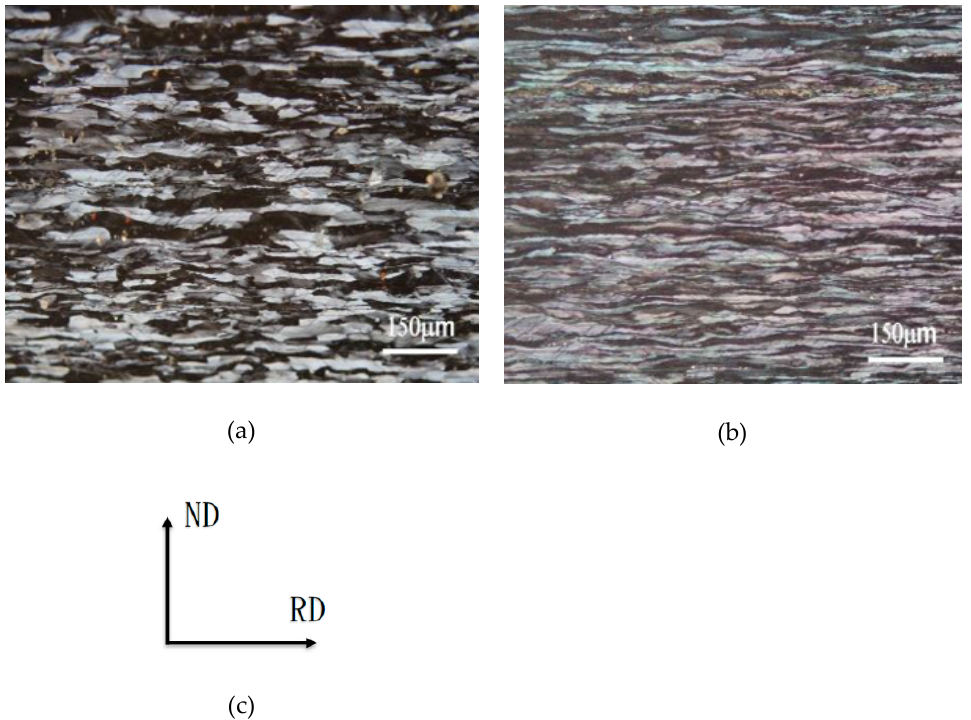
Figure 5. Optical microstructure observation of ( a ) cold rolling Alloy A (0Mn); ( b ) cold rolling Alloy B (0.8Mn); ( c ) rolling